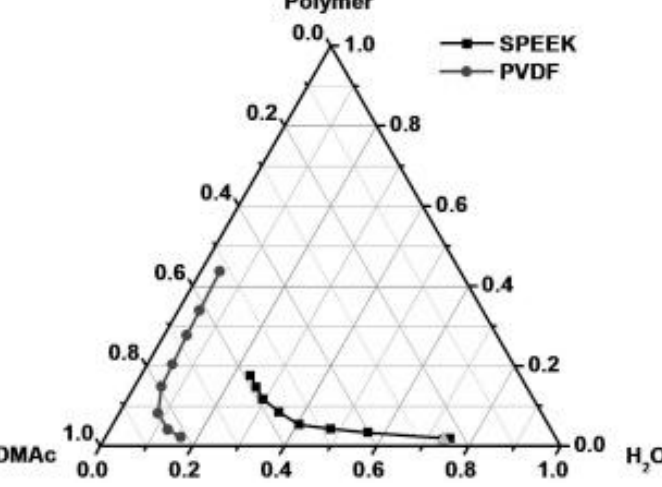
Figure 1. Cloud point curves of SPEEK / dimethylacetamide (DMAc) / H 2 O (square plot) and poly(vinylidene fluoride) (PVDF) / DMAc / H 2 O (circle plot) [32].